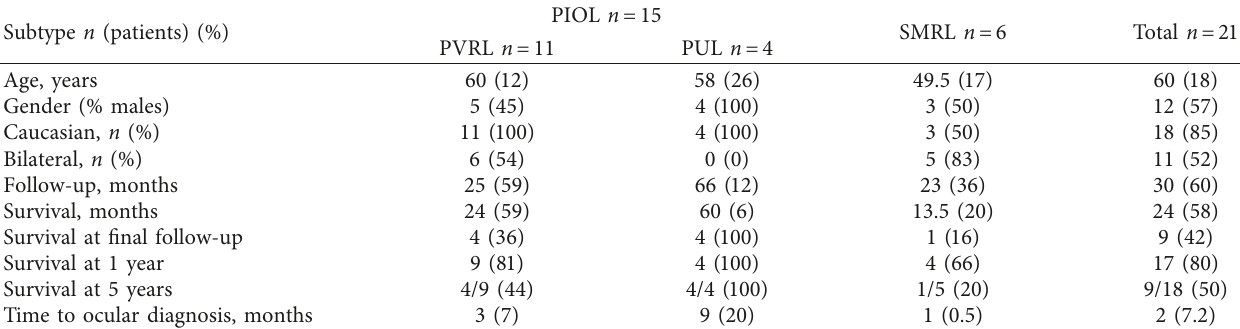
Table 1: Demographics, timing, and survival in patients with primary and systemic metastatic retinal lymphomas. Subtype n (patients) (%)